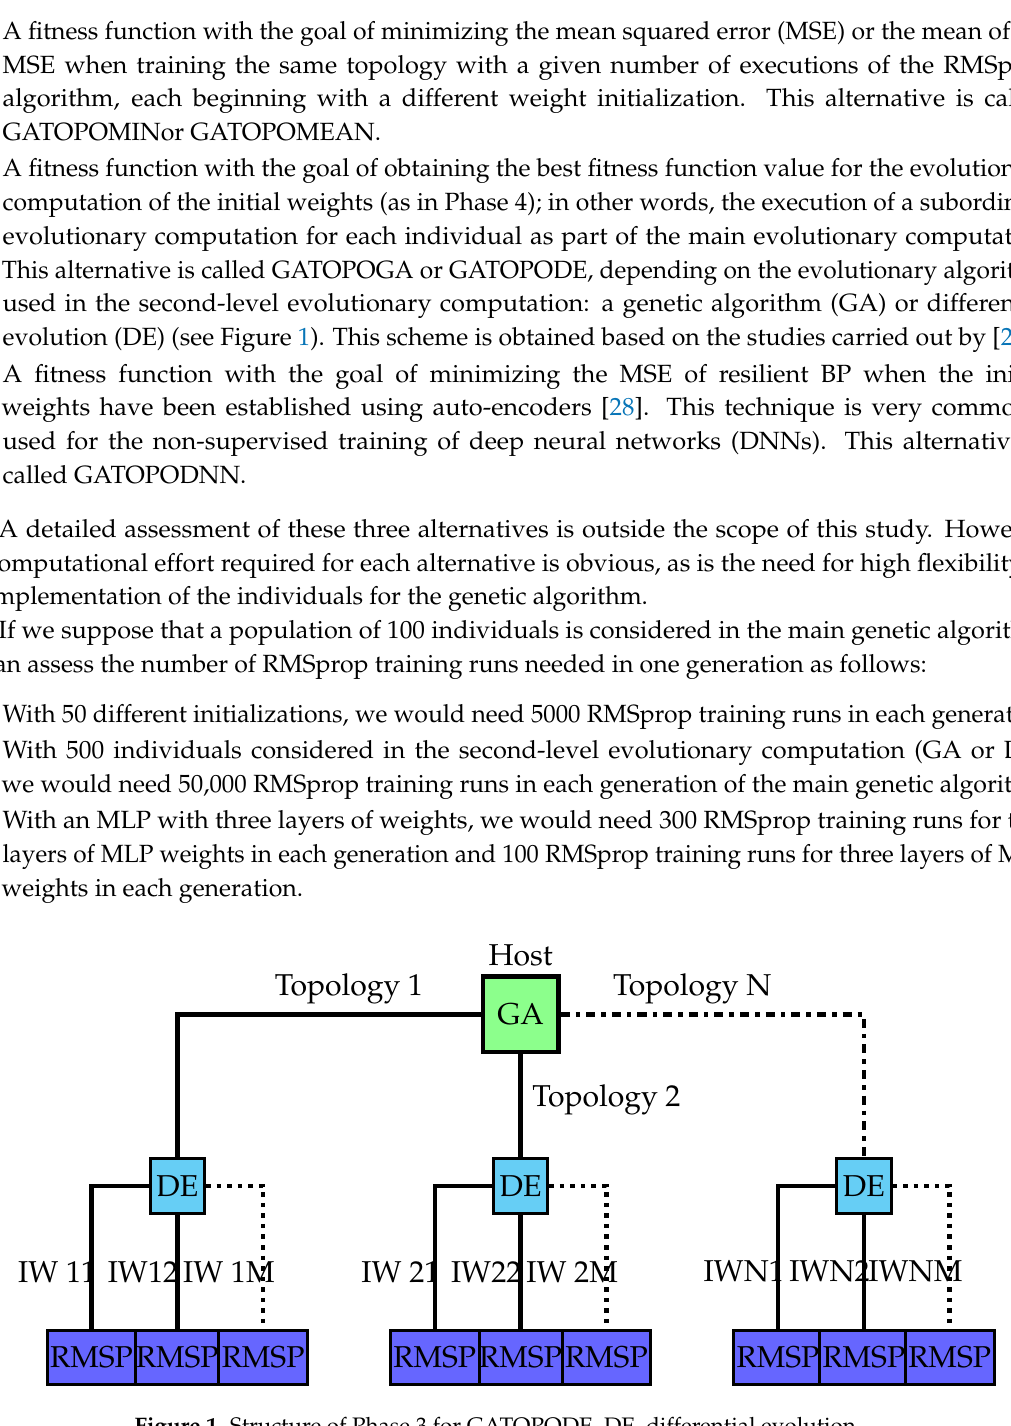
Figure 1. Structure of Phase 3 for GATOPODE. DE, differential